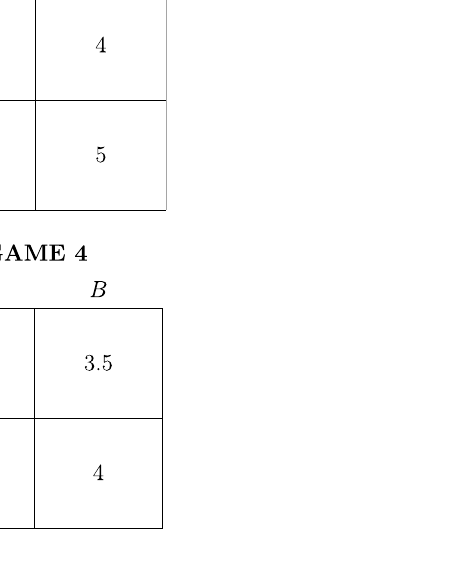
Figure 1. The four stag hunt games of the